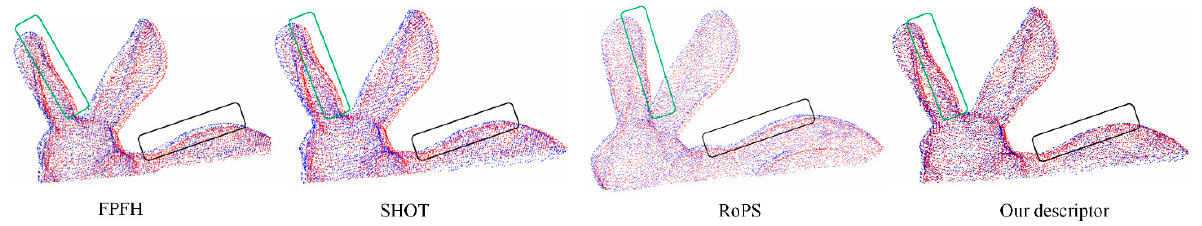
Figure 9. Enlarged result of Bunny based on four descriptors. From left to right is the result of FPFH, SHOT, RoPS, and our descriptor, respectively. The source point cloud is shown in blue, and the target point cloud is shown in red. The black box shows details of the rabbit’s back with a sharp edge, and the green box shows details of the rabbit’s ears.